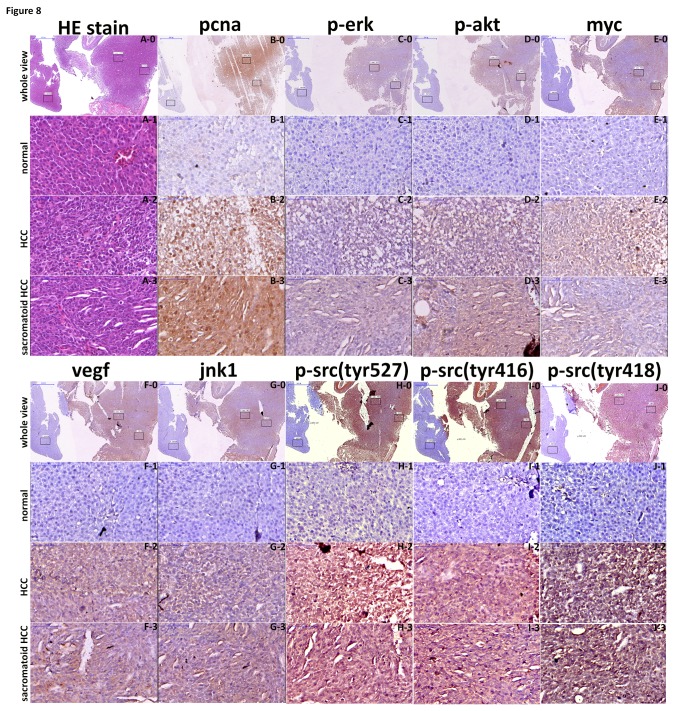
Assessment of pcna, p-erk, p-akt, myc, vegf, jnk1, p-src(tyr527), p-src(tyr416), and p-src(tyr418) signaling in HCC, sarcomatoid HCC, and adjacent normal tissue of src-overexpressing transgenic zebrafish.Liver sections from the src-overexpressing transgenic zebrafish that had developed HCC and sarcomatoid HCC, as well as adjacent normal tissue, were analyzed with H&E staining (A) and immunostaining for pcna, p-erk, p-akt, myc, vegf, jnk1, p-src(tyr527), p-src(tyr416), and p-src(tyr418) (B~J). All slides, comprising normal tissue (1), HCC (2) and sarcomatoid HCC (3), were analyzed using Panoramic Viewer under lower resolution (0) and subsequently at higher resolution. (A0-A3) H&E stain, (B0~B3) pcna protein expression, (C0~C3) p-erk expression level, (D0~D3) p-akt expression level, (E0~E3) myc protein expression, (F0~F3) vegf protein expression, (G0~G3) jnk1 protein expression, (HG0~H3) p-src(tyr527) level, (I0~I3) p-src(tyr416) level, and (J0~J3) p-src(tyr418) expression level were assessed. Scale bars: 50 μm.